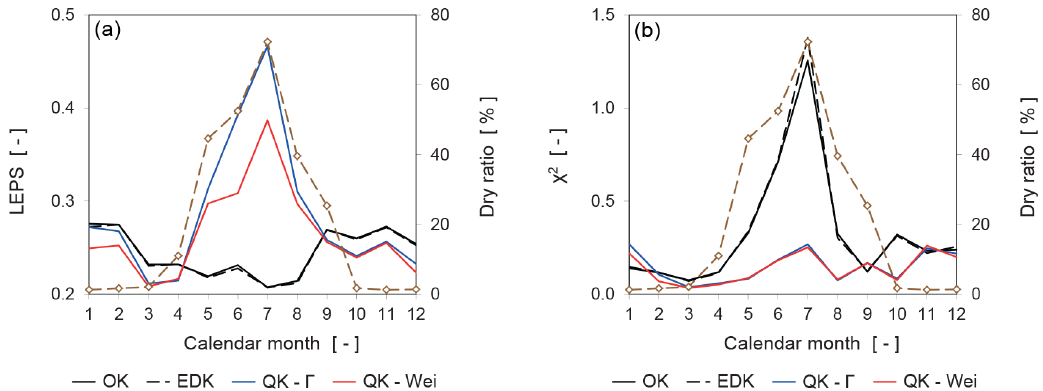
Figure 12. Evolution of the two objective functions for the error distribution over 12 calendar months: LEPS (a) and χ 2 (b) . Note that the dry ratio (dashed brown line) is indicated as a percentage on the right